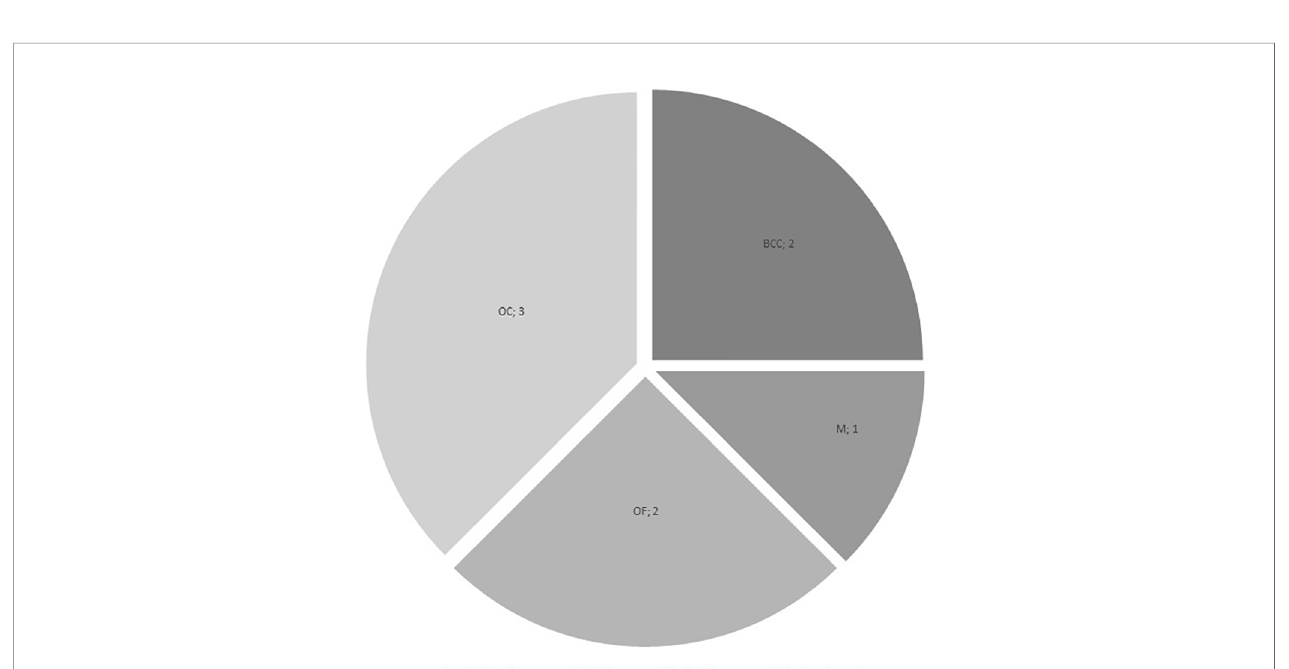
FIGURE 3 | Additional neoplasms in the Gorlin Cohort (BCC, basal cell carcinoma; M, meningioma; OC, odontogenic cysts / tumors; OF, ovarian fi